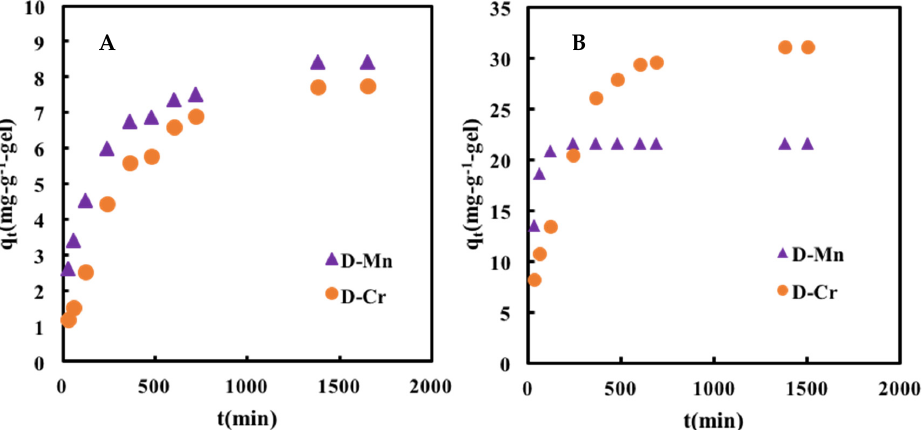
Figure 6. Comparison of the adsorption kinetics of the D-Mn and D-Cr gels at the initial As(III) concentration of ( A ) 20 mg L − 1 and ( B ) 100 mg L − 1 , concentration of ( A ) 20 mg L − 1 and ( B ) 100 mg L − 1 , respectively.